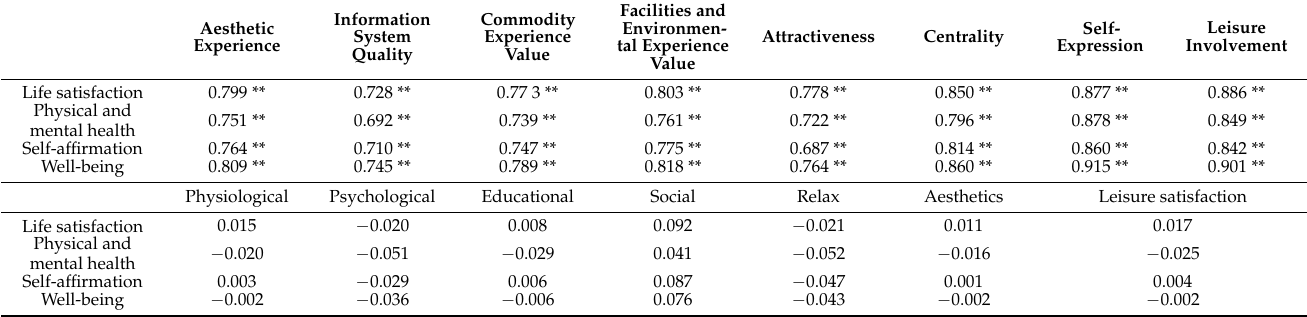
Table 7. Correlation analysis of environmental experience value, leisure involvement, leisure satisfaction, and well-being. Aesthetic